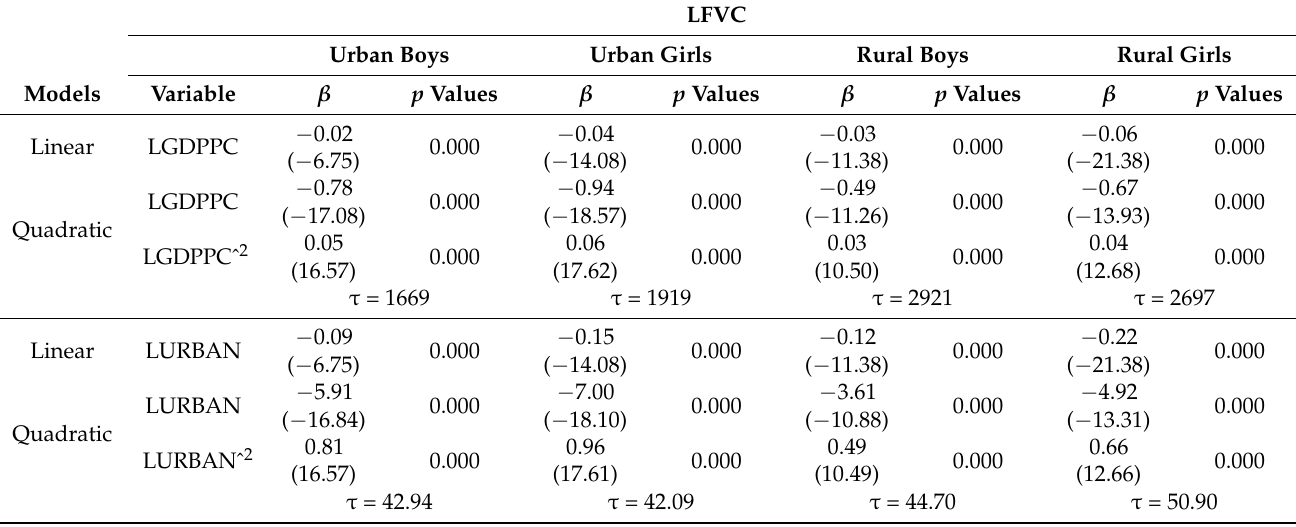
Table 2. Econometric Estimates of the Relationship between Socio-economic indicators and Lung Function of Students.